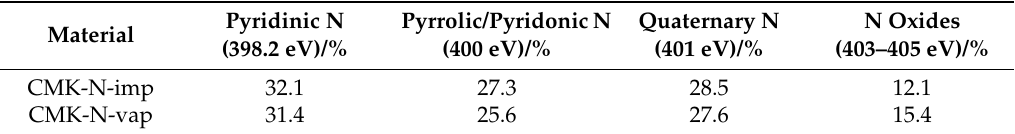
Table 2. Nitrogen speciation from XPS analyses of N-doped carbon materials.